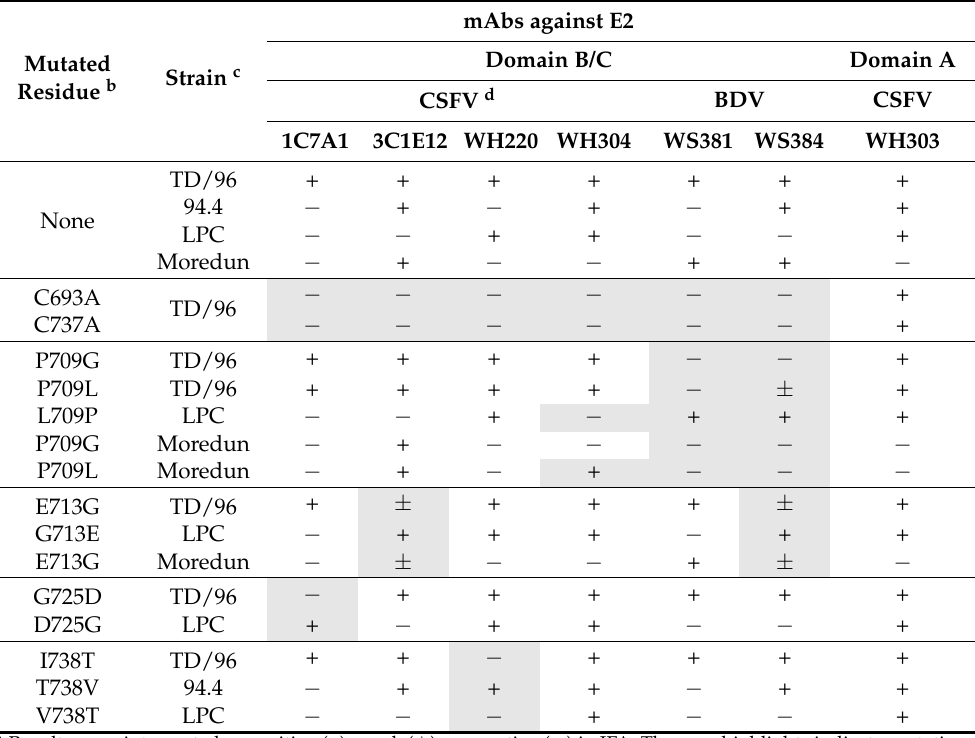
Table 4. Identification of critical residues of E2-specific mAbs binding by site-directed mutagenesis of CSFV and BDV E2 proteins a